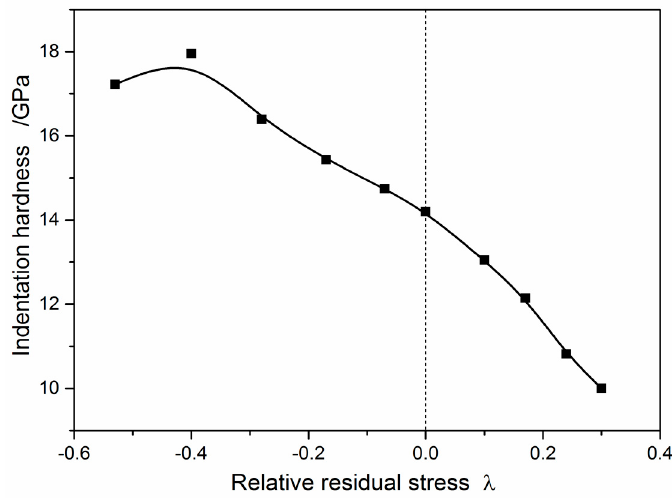
Figure 6. Hardness as a function of relative residual stress. (The curve is fitted by B-spline with the MD numerical result points).